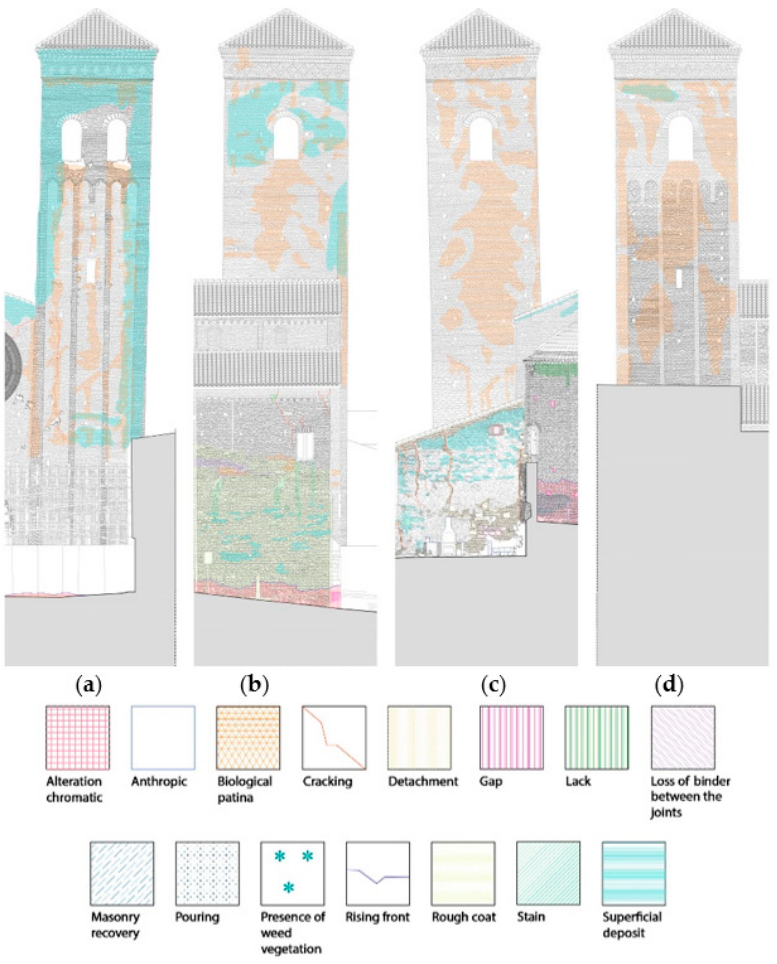
Figure 10. Bell tower decay: ( a ) front North; ( b ) front Est; ( c ) front South; ( d ) front West.